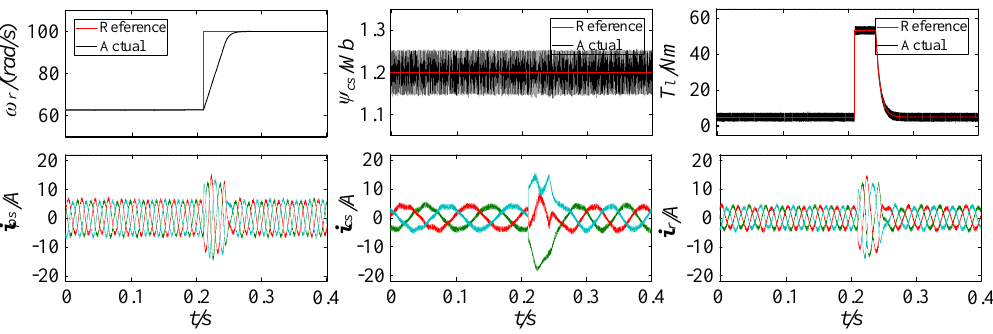
Figure 14. Speed changes from 62.8 rad/s to 100 rad/s at 5 Nm load.